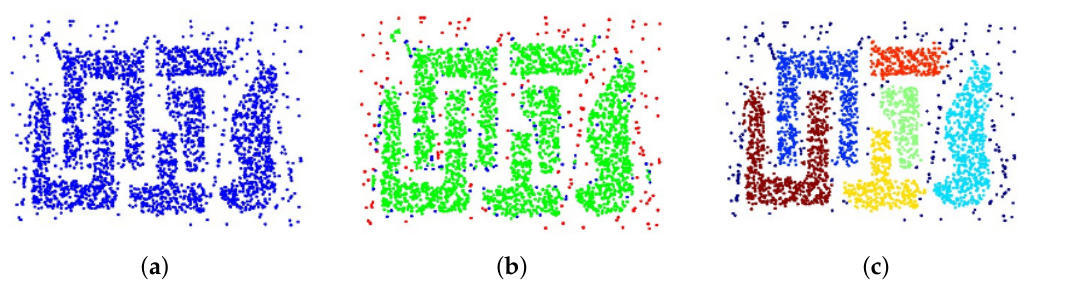
Figure 5. The explanation of the DBSCAN algorithm. ( a ) is the original distribution of the dataset; ( b ) is the distribution of different type of the dataset: core (green) points, border (blue) points and noise (red) points; ( c ) is the cluster results with the DBSCAN algorithm applied to the